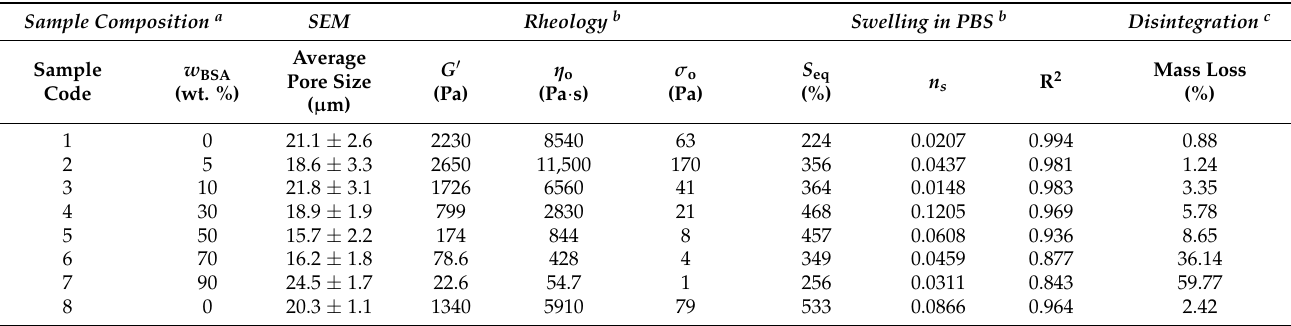
Scheme 1. Structure of chemicals used in this study. The structural subdomains of BSA are high- lighted by different colors (reprinted with permission from Ref. [45] copyright 2012 Elsevier Ltd.). Table 1. Composition and some characteristics of hydrogels.